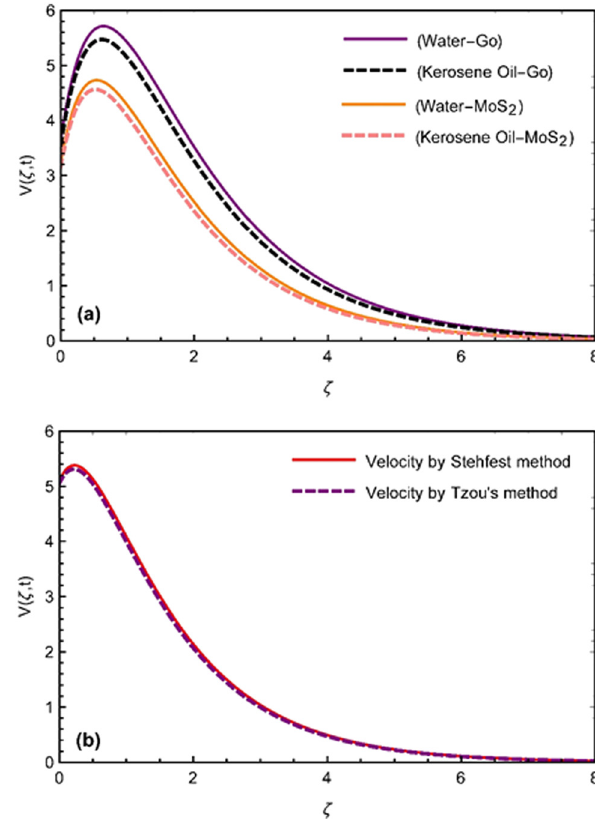
Figure 6: ( a and b ) Change in temperature for ( a ) φ and ( b ) ρ with β = 0.5, Pr = 5.6, Gr = 4.7, Gm = 4.2, Sc = 3.9, t =